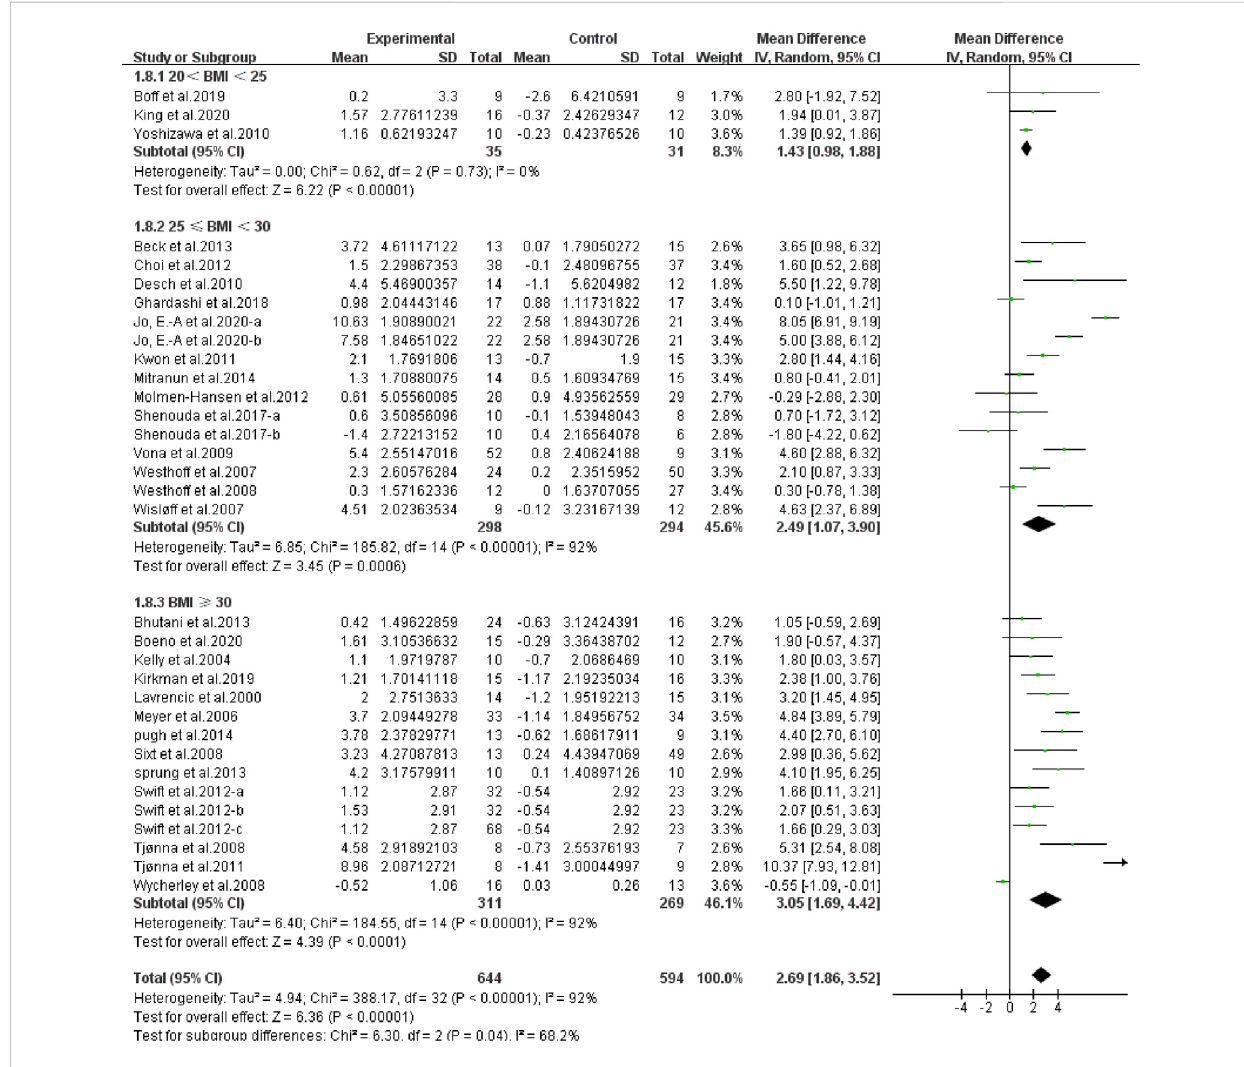
FIGURE 9 Meta-analysis results of the effect of continuous aerobic exercise on FMD in normal weight, overweight, or obese people. The pooled estimates wereobtained fromrandom effects analysis. Diamonds indicated thesizeof theeffectof eachstudy summarizedas WMD. The sizeof theshadedsquare was proportional to the percentage weight of each study. Horizontal lines represented the 95% CI and the vertical dashed line represented the overall